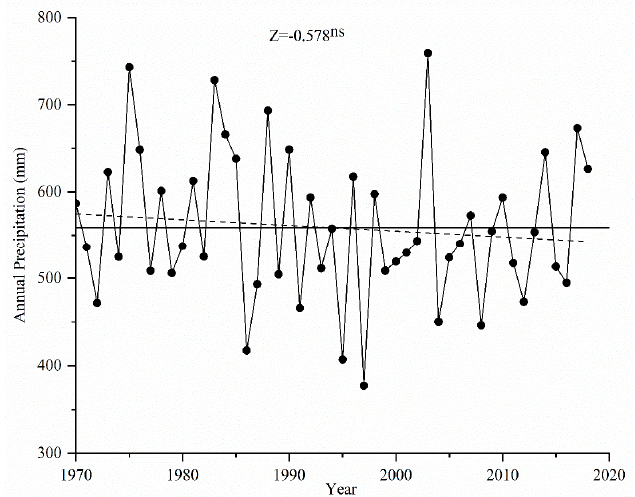
Figure 5. Observed annual average precipitation in the Beiluo River Basin. Horizontal solid line indicates the mean values, and dotted line represents the trend line. Z statistic could be acquired from the M–K trend test (ns, not significant at 0.1 p ).